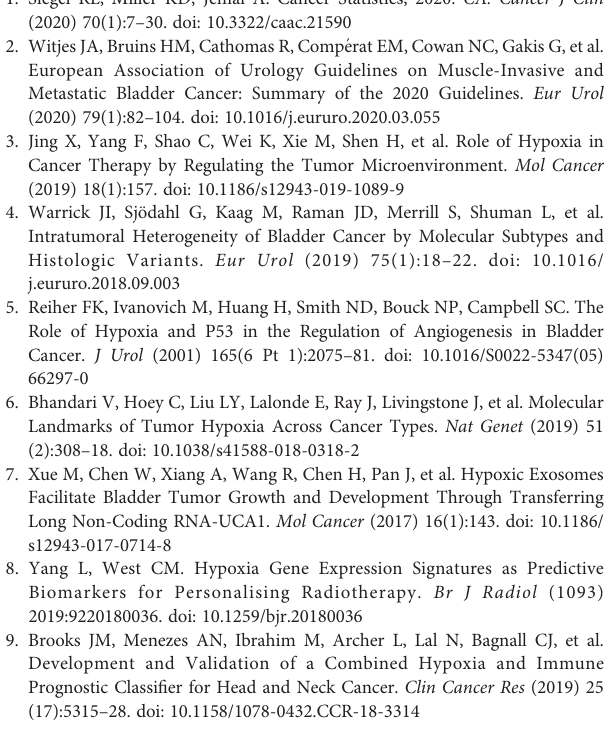
Supplementary Figure 8 | Hypoxia risk score correlated with immune characters of TME and predicted the clinical response of ICB in the female subgroup in TCGA- BLCA. (A) Differences in activities of the cancer immunity cycles between high- and low-risk score groups. (B) The correlations between the hypoxia risk score and several immune cells. (C) The correlations between the hypoxia risk score and T cell in fl amed score (TIS). (D) The correlations between hypoxia risk score and the enrichment scores of immunotherapy-predicted pathways. (E) The correlations between hypoxia risk score and immune checkpoints. Supplementary Figure 9 | Hypoxia risk score correlated with immune characters of TME and predicted the clinical response of ICB in the male subgroup in TCGA- BLCA. (A) Differences in activities of the cancer immunity cycles between high- and low-risk score groups. (B) The correlations between the hypoxia risk score and several immune cells. (C) The correlations between the hypoxia risk score and T cell in fl amed score (TIS). (D) The correlations between hypoxia risk score and the enrichment scores of immunotherapy-predicted pathways. (E) The correlations between hypoxia risk score and immune checkpoints. Supplementary Figure 10 | Hypoxia risk score correlated with immune characters of TME and predicted the clinical response of ICB in the older subgroup in TCGA-BLCA. (A) Differences in activities of the cancer immunity cycles between high- and low-risk score groups. (B) The correlations between the hypoxia risk scoreandseveralimmunecells. (C) Thecorrelationsbetweenthehypoxiariskscore and T cell in fl amed score (TIS). (D) The correlations between hypoxia risk score and the enrichment scores of immunotherapy-predicted pathways. (E) The correlations between hypoxia risk score and immune checkpoints.